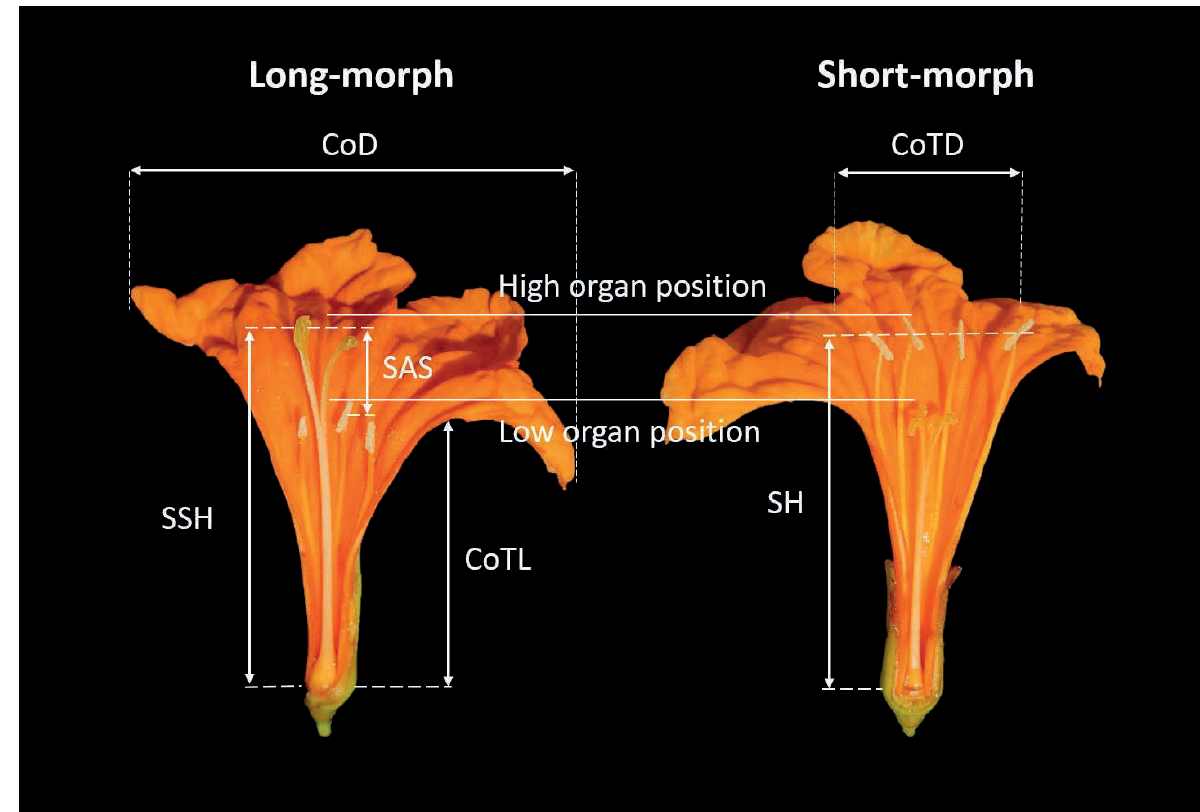
Figure 1 – Floral morphology of C. subcordata , showing the position of the anther and stigma, as well as the measurements of the floral characters. CoD: corolla diameter; CoTD: corolla tube diameter; CoTL: corolla tube length; SSH: style plus stigma height; SH: stamen height; SAS: stigma-anther